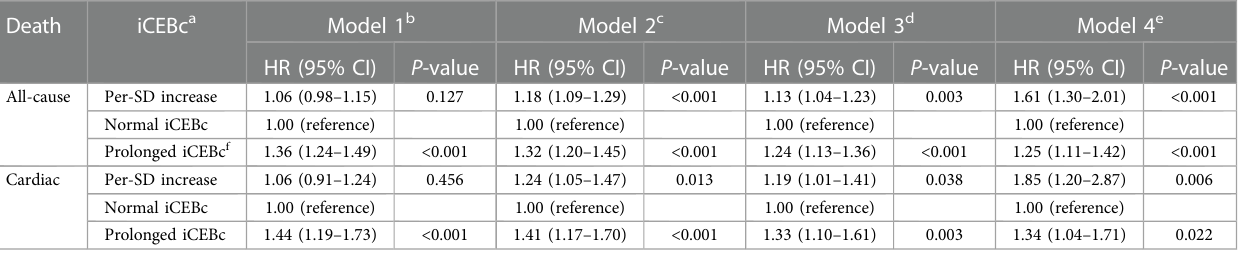
TABLE 2 Hazard ratios for the association between iCEBc and All-cause death and cardiac death.